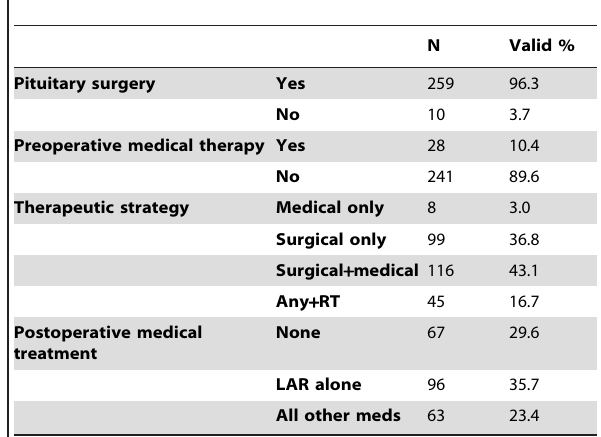
Table 1. Patients and tumor characteristics. Table 2. Therapeutic